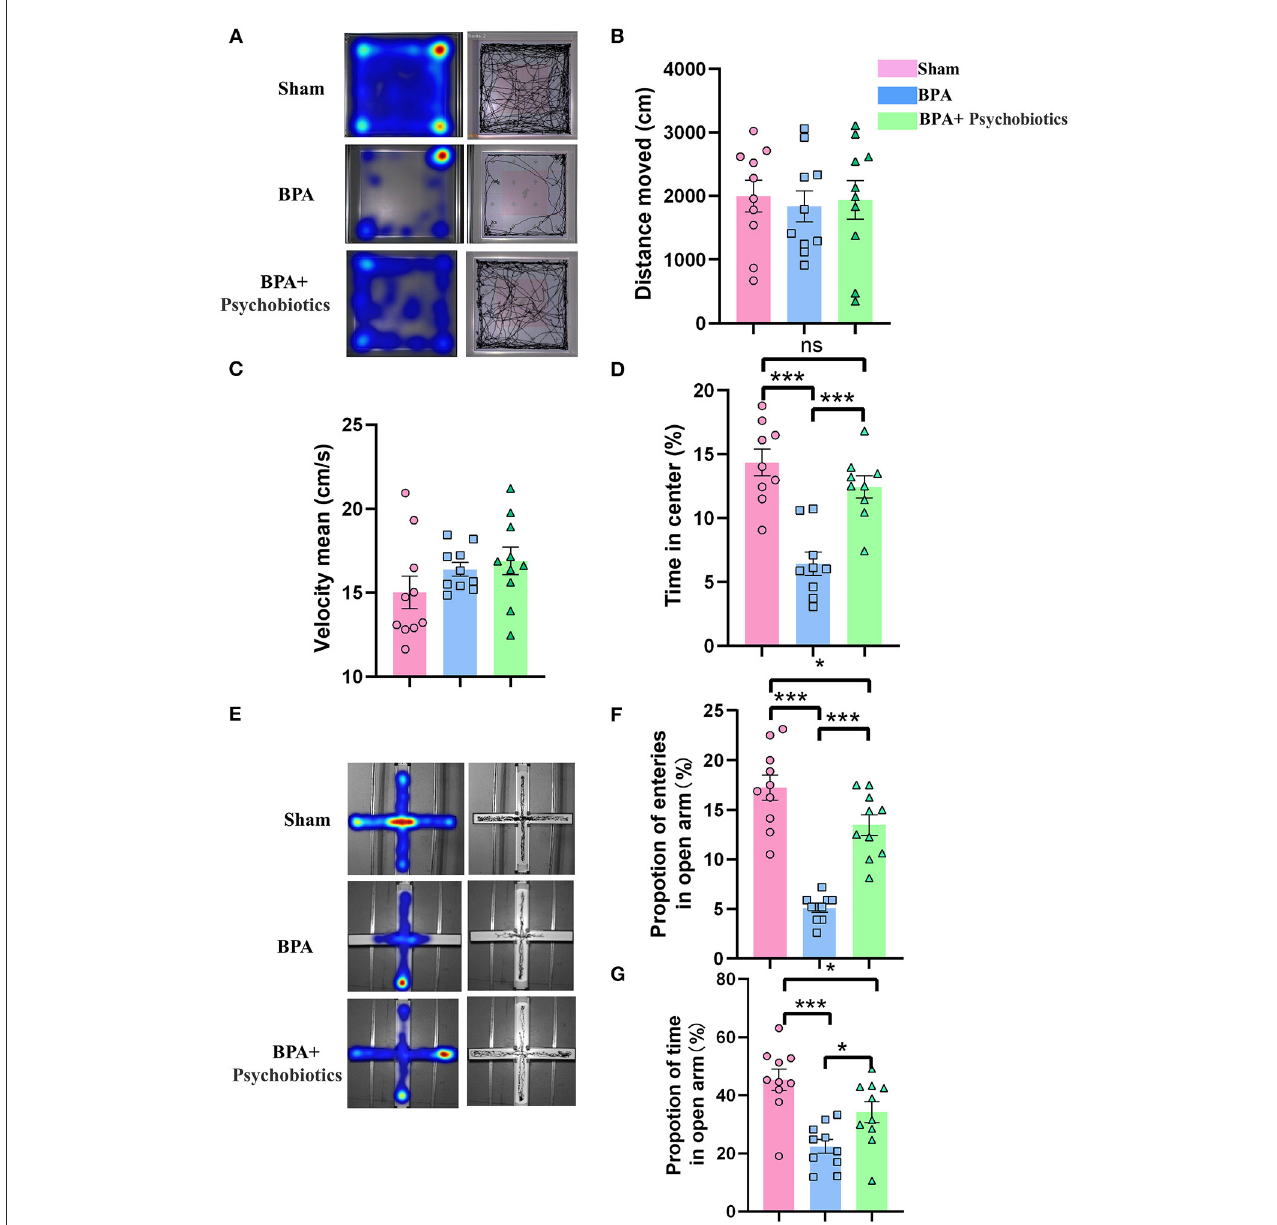
FIGURE6 Effects of PB supplementation on anxiety-like behaviors in BPA mice. (A) OFT trajectory diagram. (B) The movement distance from OFT tests among the three groups. (C) The movement speed from OFT tests among the three groups. (D) The residence time in the central area from OFT among groups (E) EPM trajectory diagram. (F) EPM: The proportion of open arm entry times in the three groups. (G) EPM: The open arm residence time among groups. N = 10 per group. Ns = no statistical significance, * P < 0.05, *** P < 0.001. Ordinary one-way ANOVA was used for data analysis. BPA, brachial plexus avulsion; PB, psychobiotics; OFT, open field test; EPM, elevated plus-maze